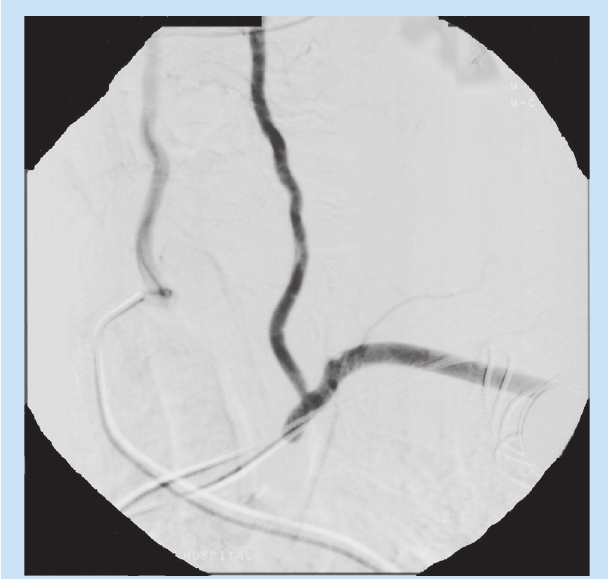
Fig. 5. Digital subtraction angiogram demonstrating LSA opacification due to retrograde flow from the left vertebral artery (as a subclavian artery steal